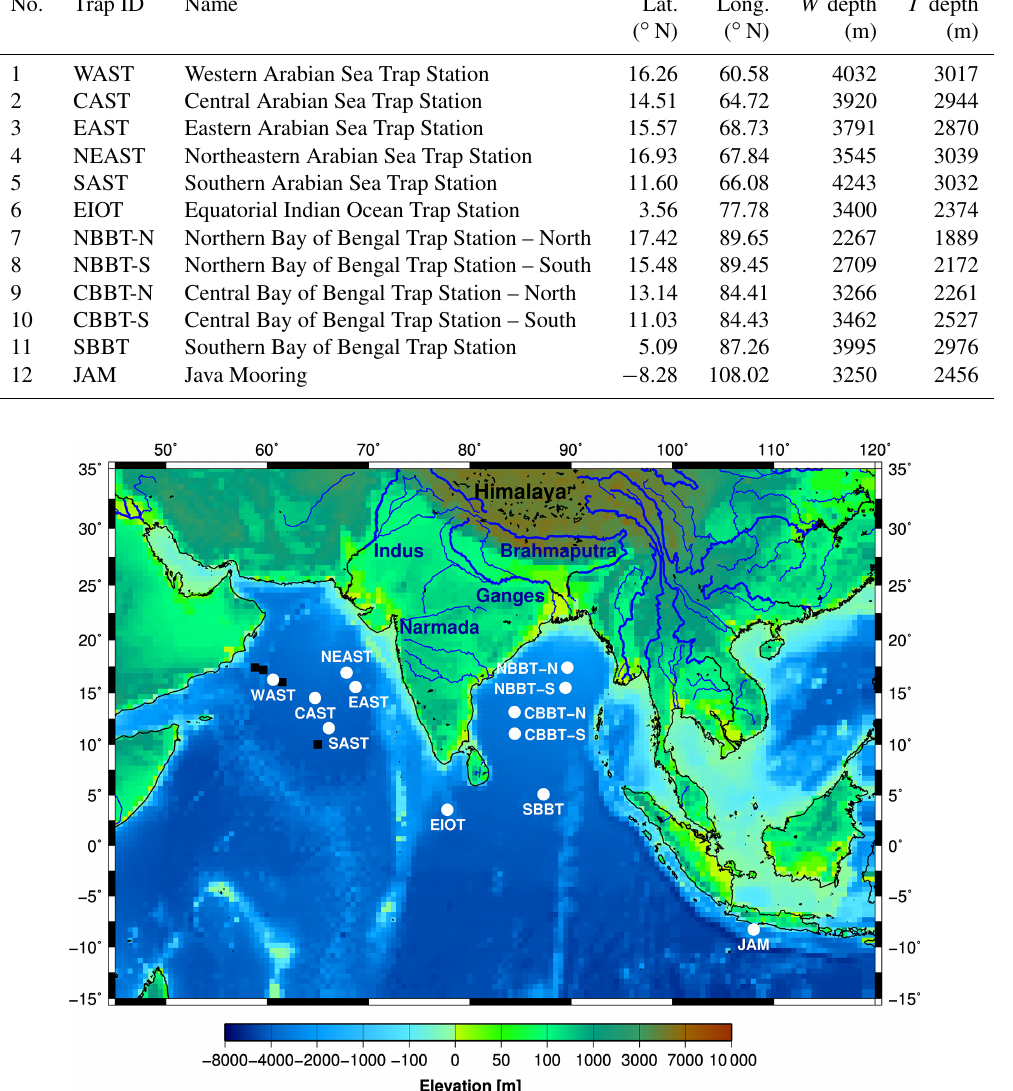
Figure 1. Bathymetric chart of the northern Indian Ocean and the adjacent land mass. Data were obtained from http://ingrid.ldeo.columbia. edu/SOURCES/WORLDBATH/ (last access: 23 September 2009). White circles show the sediment trap sites operated by the joint Indo– German and Indonesian–German projects (see Table 1). The black circles represent the US JGOFS sediment trap sites M2 to M5 (Honjo et al., 1999; Lee et al.,